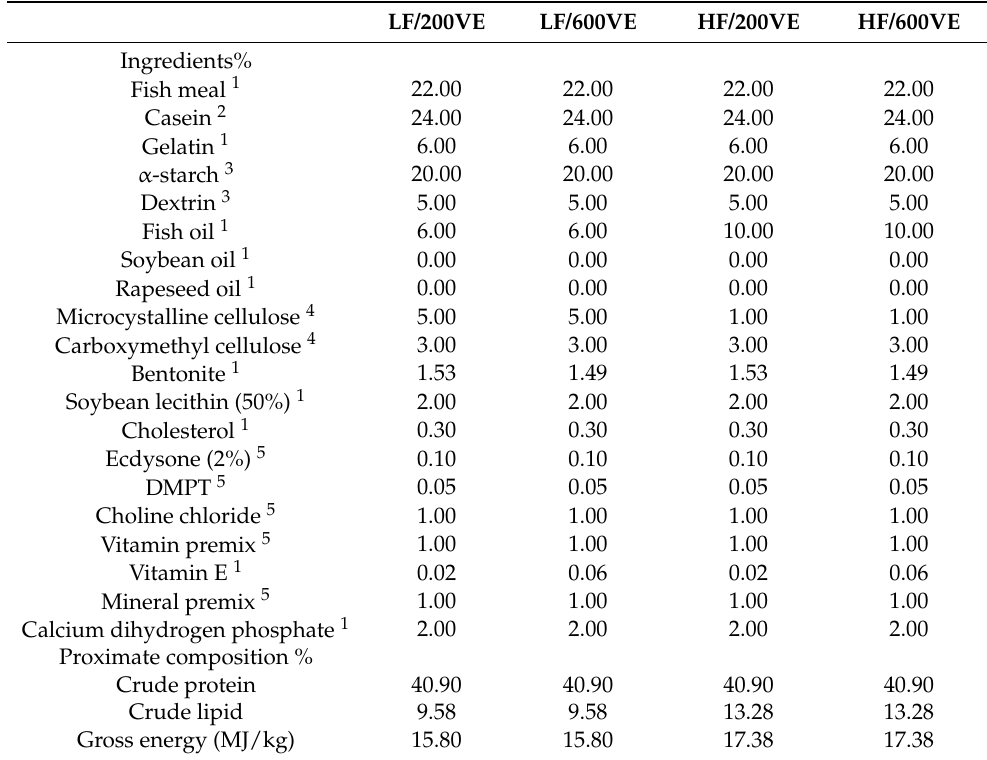
Table 1. Formulation and proximate composition of the experimental